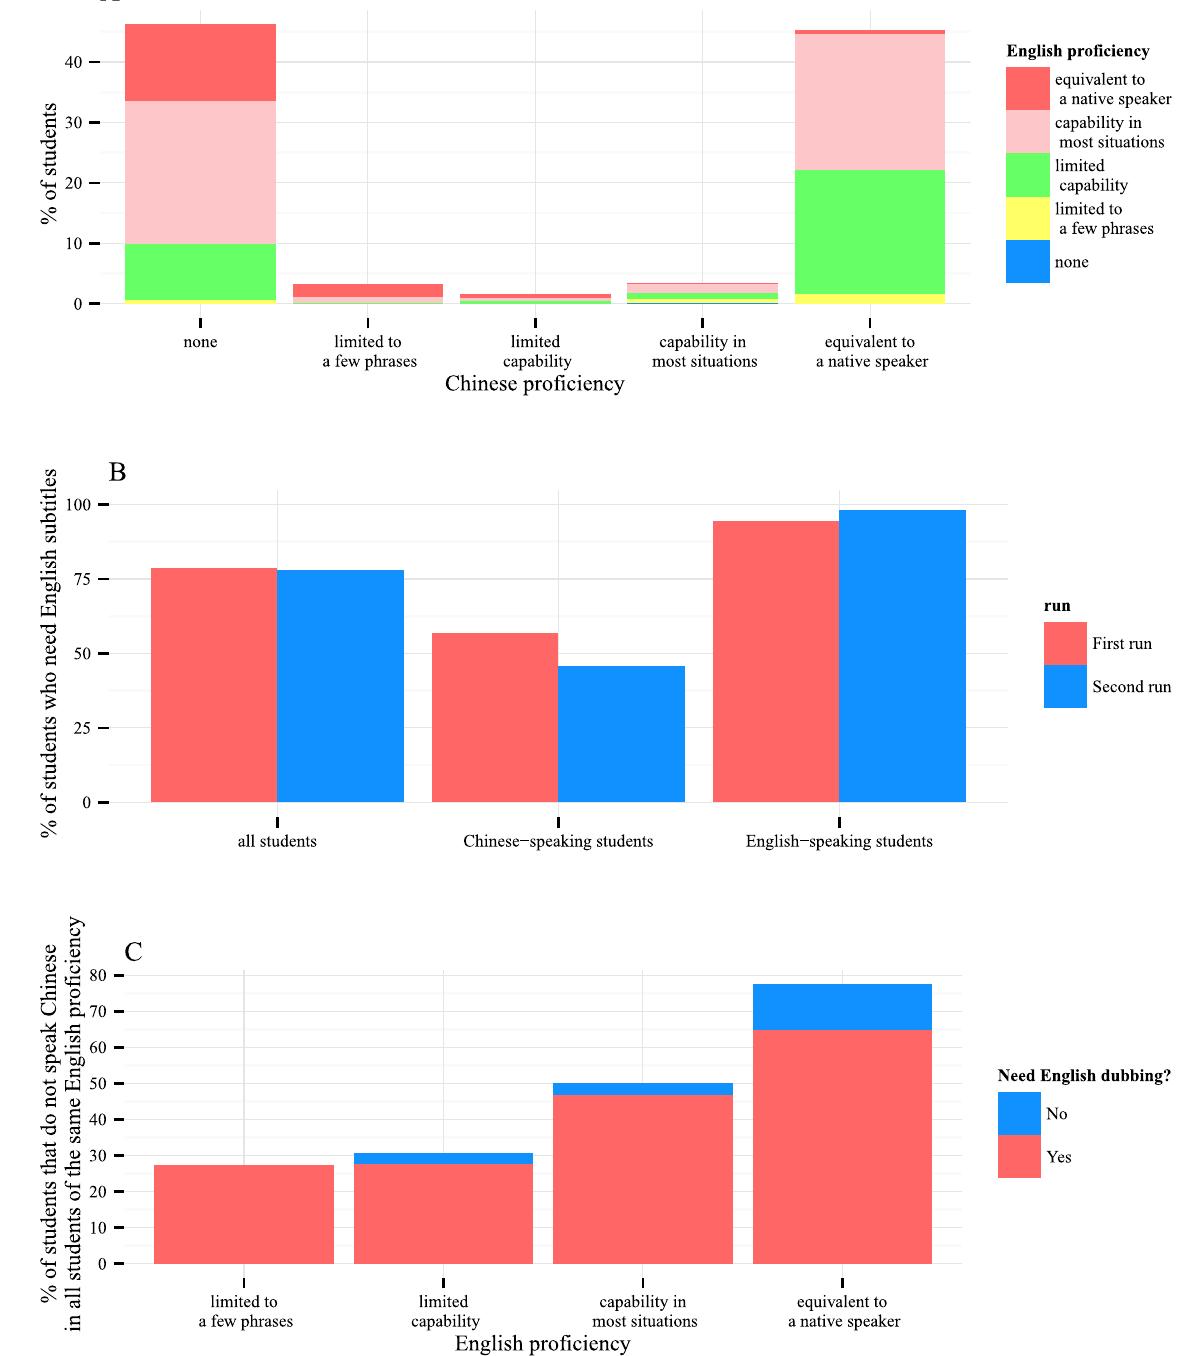
Figure 3. English support is needed in an international MOOC. (A) About half of the students did not know Chinese. (B) English subtitles were welcomed by both English- and Chinese-speaking students. (C) With English subtitles available, over 80% of non-Chinese-speaking students requested English dubbing.